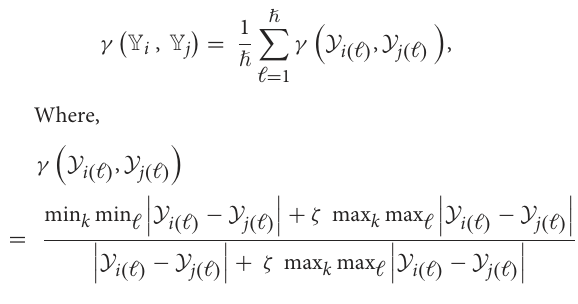
If Y i ( dependent ) and Y j ( independent ) are two distinct